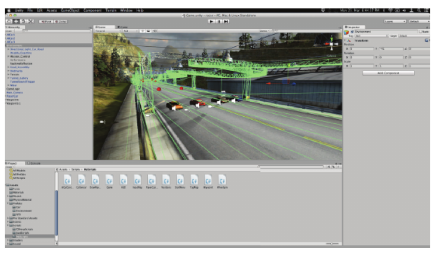
Figure 2: The race car and its associated trigger detection area are highlighted in the (green) wireframe mesh. Figure 3: The interface of the Unity